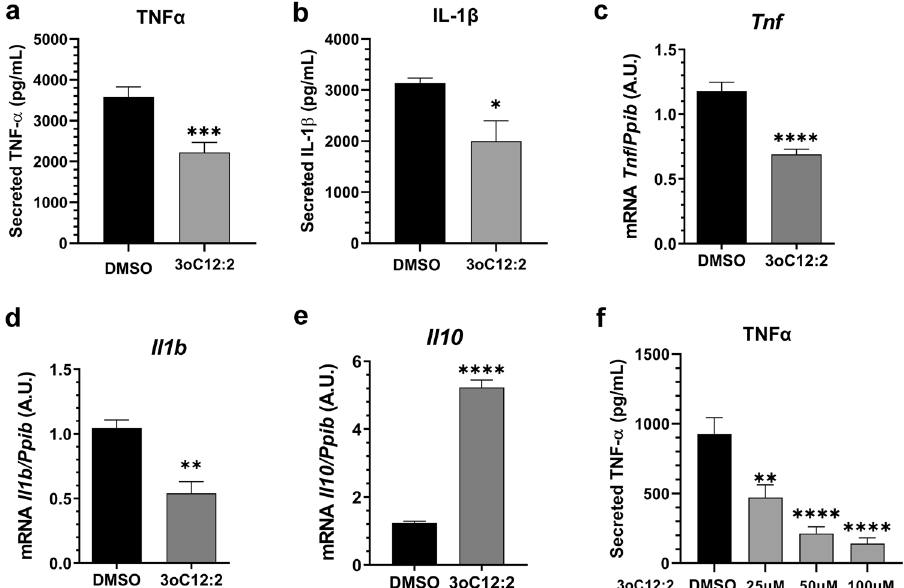
Figure 1. 3-oxo-C12:2-HSL decreases pro-inflammatory cytokine secretion by immune cells. Secreted TNFα ( a ) and IL-1β ( b ) levels were measured by ELISA from supernatant of RAW264.7 macrophages stimulated